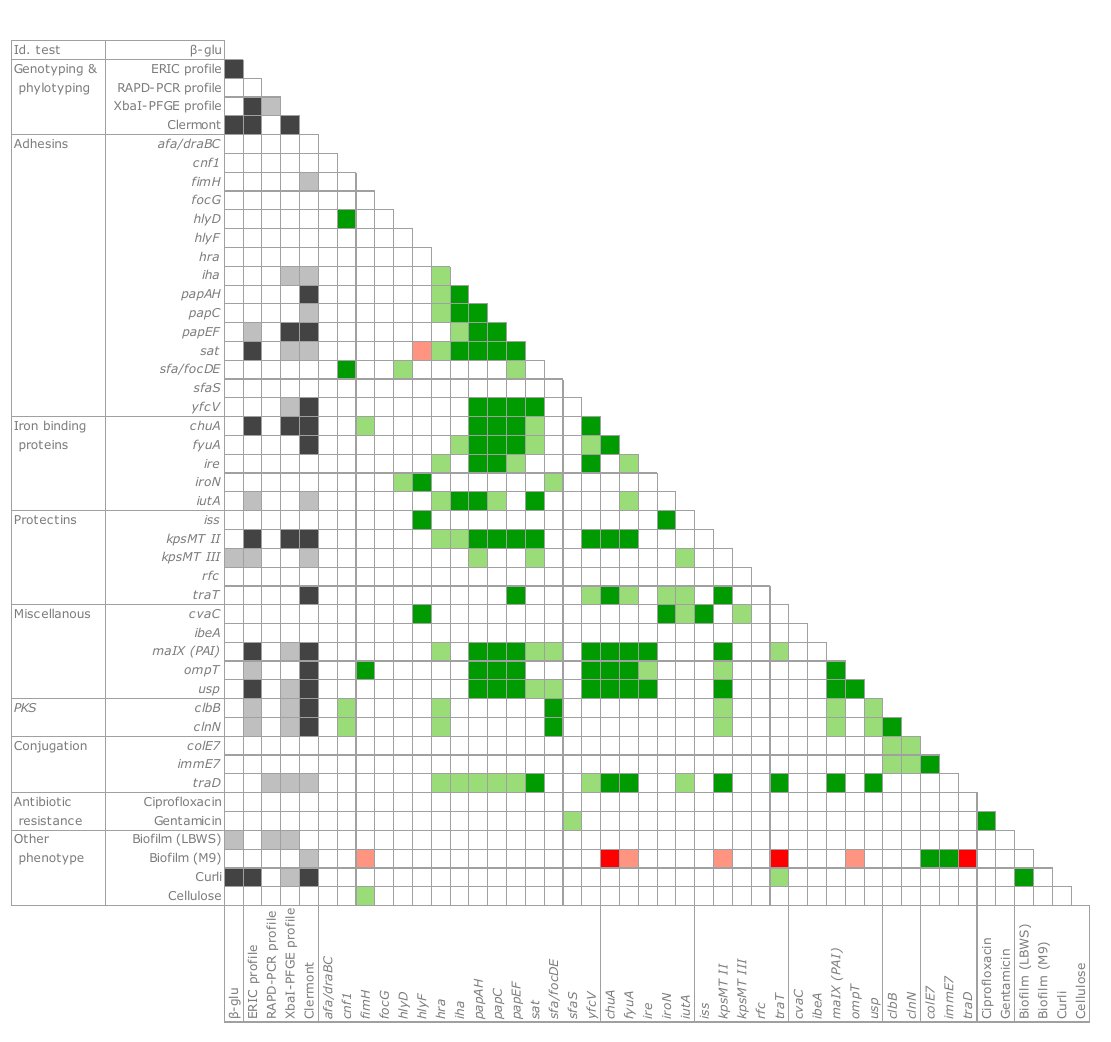
Figure 6. Genetic determinants and phenotypic properties evaluated by Cramér’s V metrics. Association with genotype/phylotype clusters, grey; positive co-occurrence, green; negative co-occurrence, red. Dark and light shades indicate the levels of statistical significance ( p < 0.01 and p < 0.05, respectively). With regards to the phenotypic features involved in bacterial adhesion, the production curli were significantly associated with the phylogroup ( p < 0.01). Although biofilm formation was not frequent, curli presented a significant co-occurrence with the biofilm in the LBWS